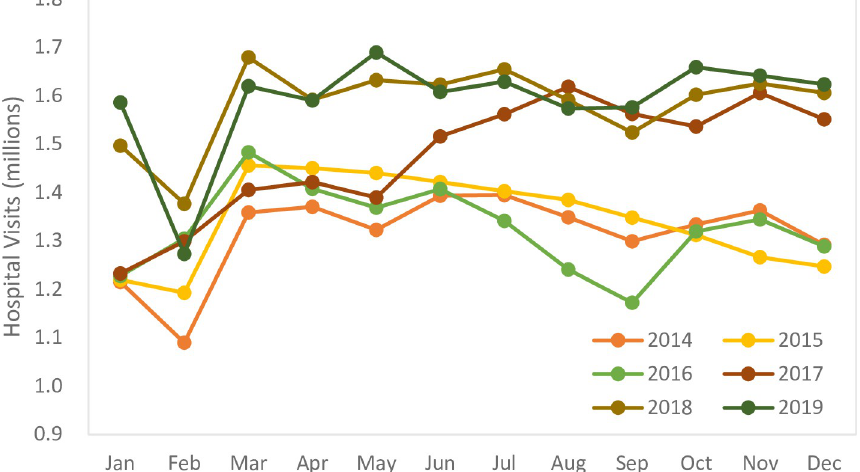
Fig 2. Graph depicting the hospital visits by month in the Hubei Province from 2014–2019 (million visits).